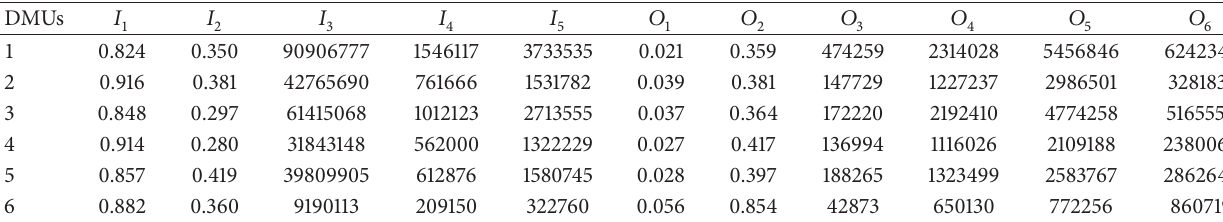
Table 2: Inputs and outputs (2006).